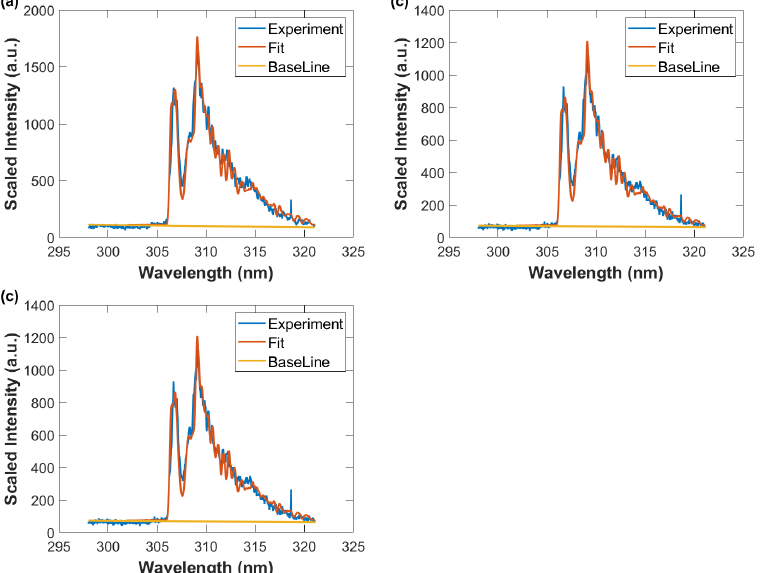
Figure 13. Wavelength calibrated and sensitivity corrected spectra average vs. wavelength, fitted data with spectral resolution of 0.35nm, and baseline. Gate width: 10 µ s, time delay ( a ) 90 µ s, T = 2780